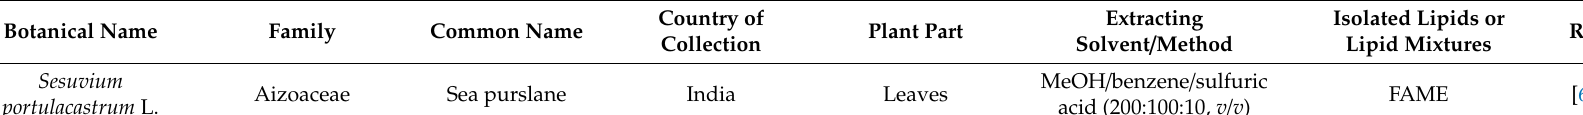
Table 1. Plant potential antimicrobial lipids or lipid-rich extracts, their origin and extraction method grouped by botanic